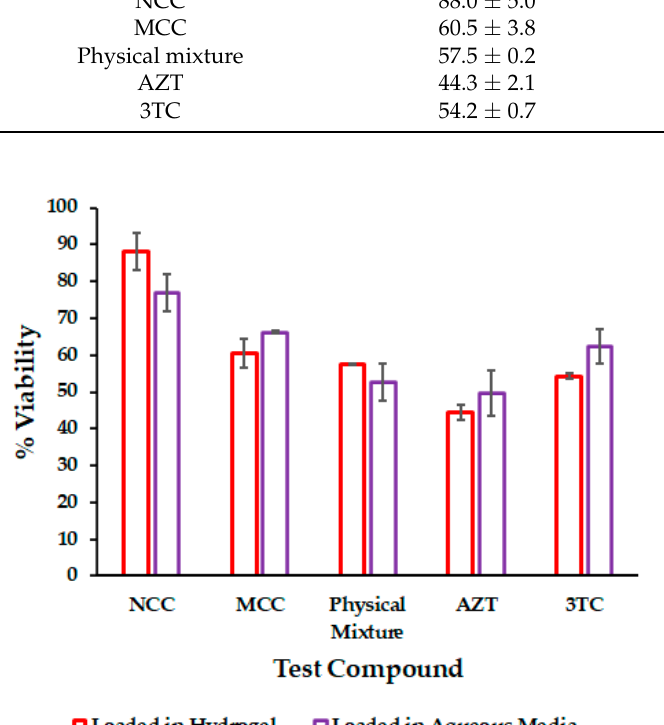
Figure 6. Summary of cytotoxicity data for NCC compared to 3TC and AZT alone, a physical mixture of 3TC and AZT and MCC and NCC loaded into a 25% w/w PF-127 hydrogel.